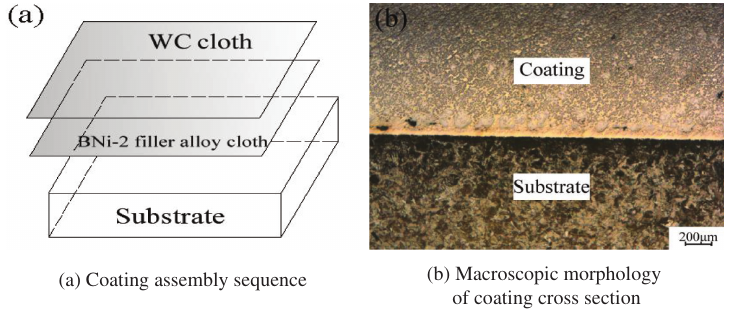
Figure 2: order of coating assembly and macroscopic morphology appearance of section:(a) coating assembly sequence, (b) macroscopic morphology of coating cross